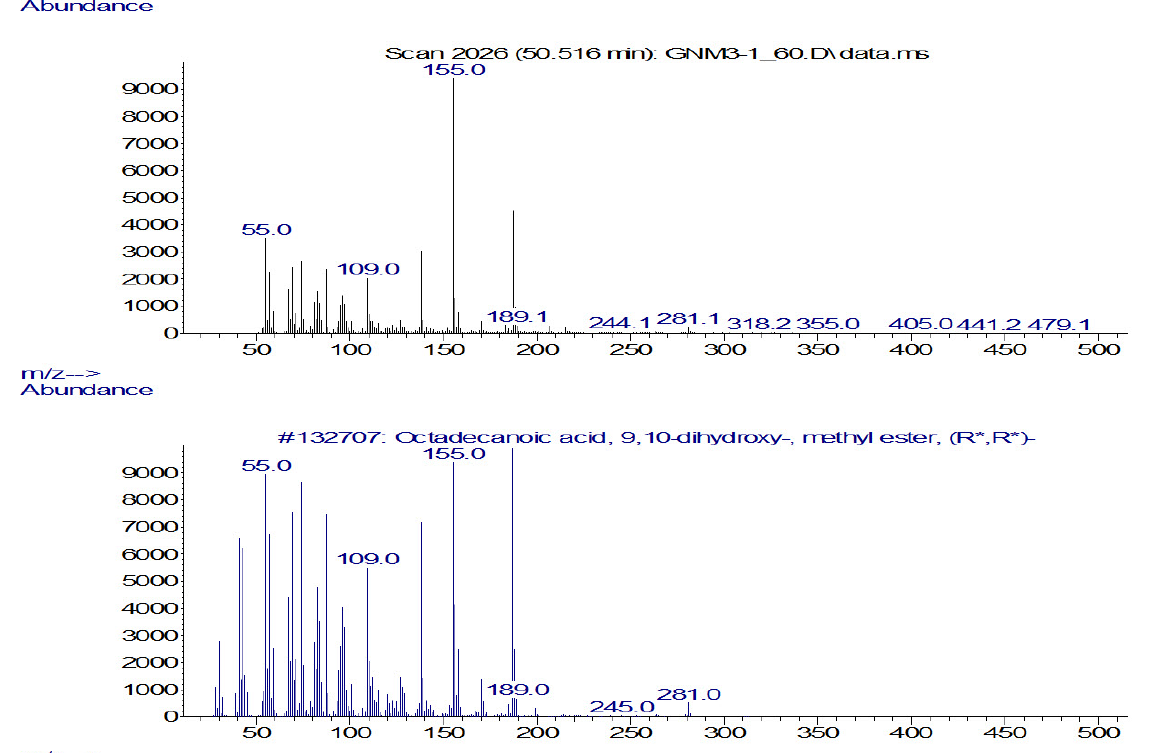
Figure 12. Mass spectra for the grinding surface core (GNM 3-1) peak at 50.516 RT (upper image) and 9, 10- dihydroxy-octadecanoic acid, methyl ester, (R, R) from the NIST mass spectral database 2.1(lower